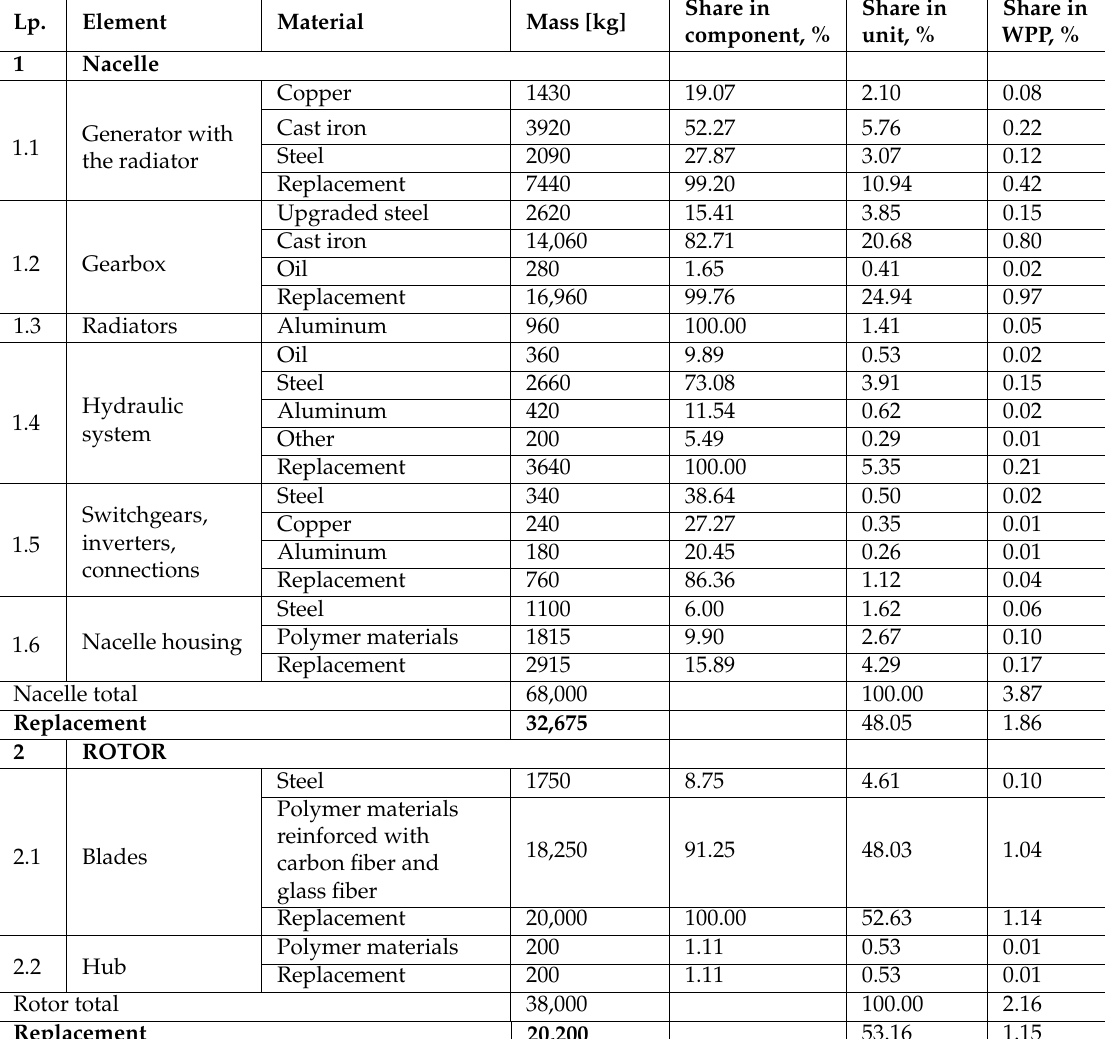
Table 2. List of the materials and elements replaced during wind power plant modernization.